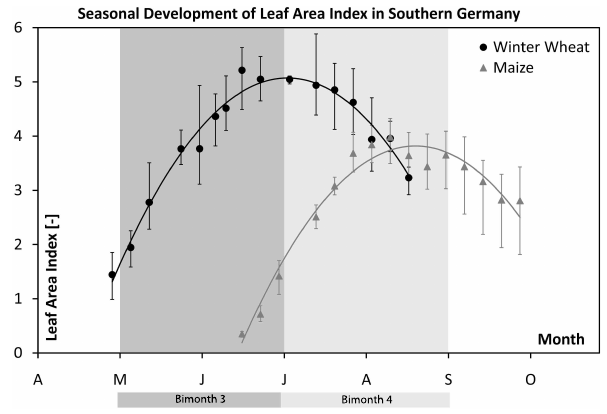
Fig. 1. Seasonal development of LAI for maize and winter wheat for a test side in southern Germany (April to October 2004). Vertical error bars represent the minimum and maximum